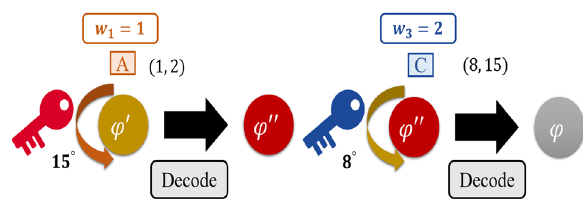
Figure 5. Simple diagram of A and C cooperating to reconstruct the